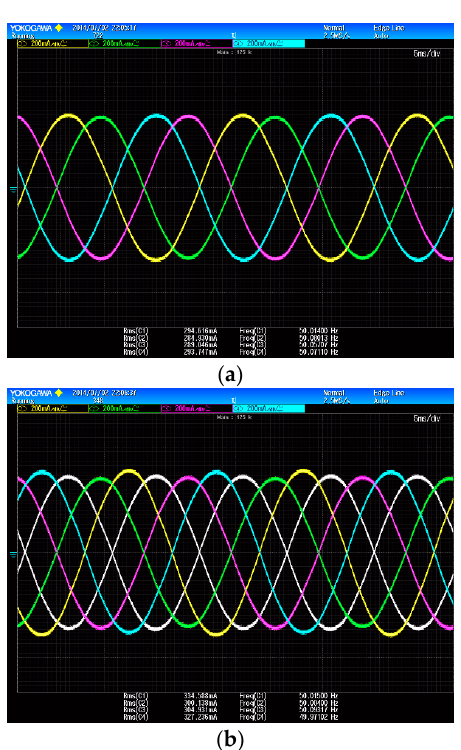
Figure 17. Six-phase motor.